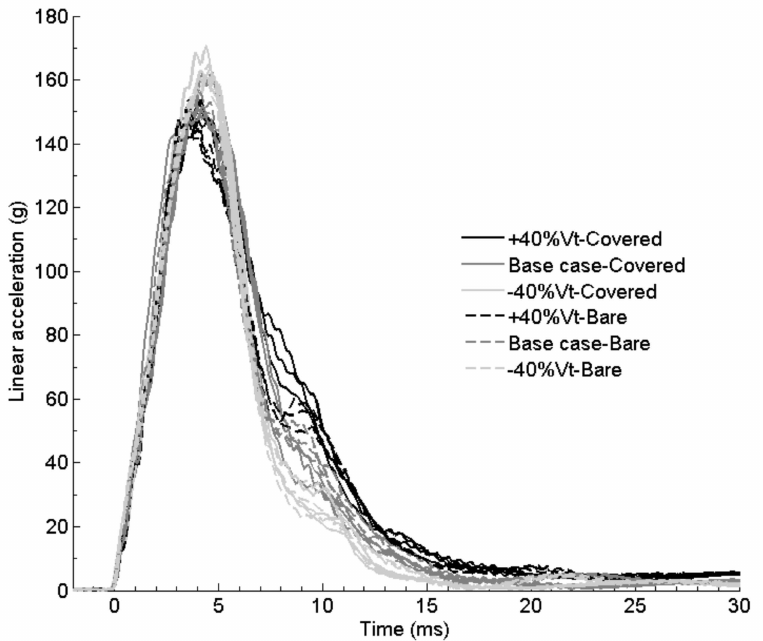
Figure 11. Resultant linear acceleration for the right side impacts. Solid lines correspond to covered headform and dashed lines correspond to bare headform test.